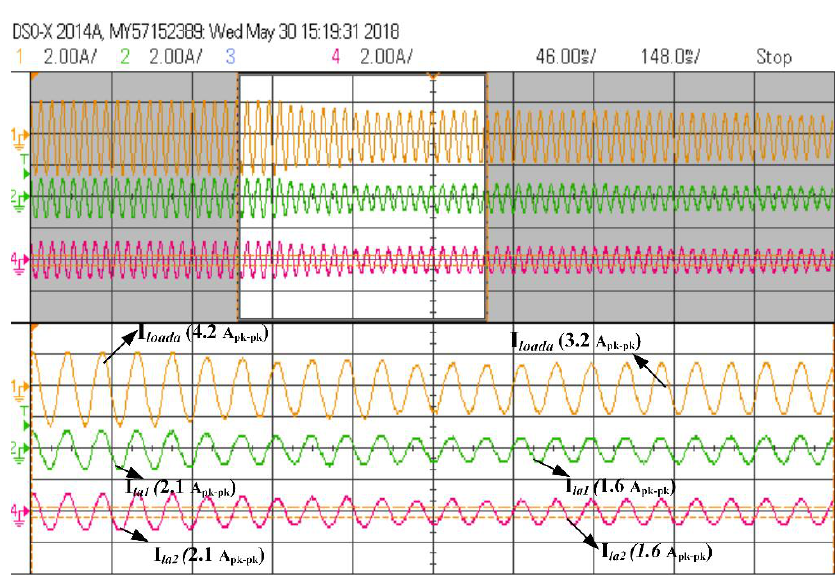
Figure 25. Parallel operation for decrease in load.